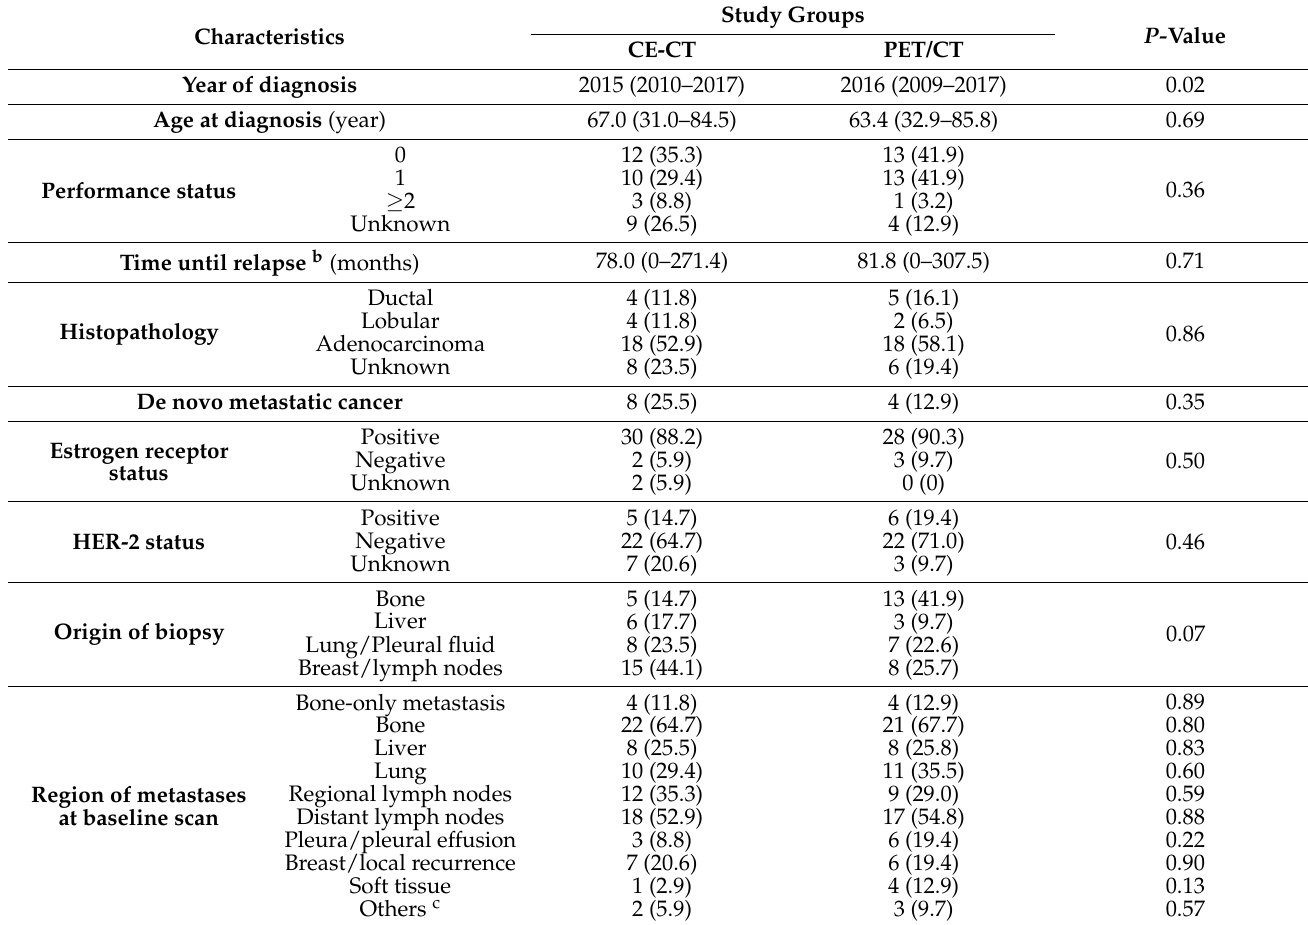
Table 2. Clinicopathological characteristics of metastatic disease a .